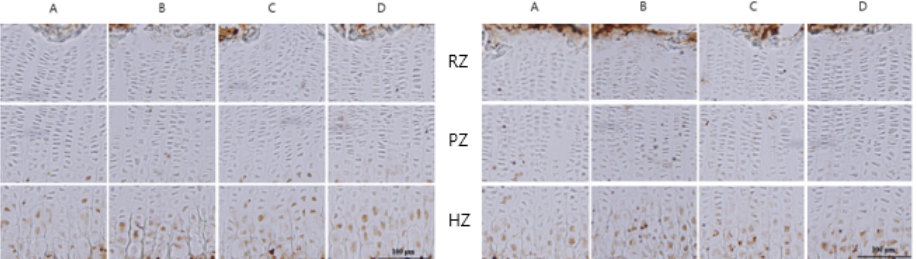
Figure 8. Immunohistochemical localizations of insulin-like growth factor-1 and bone morphoge- netic protein-2 on the proximal tibial growth plate in rats. ( A ) control, ( B ) rhGH 200 µg/kg (s.c.), ( C ) HT042 100 mg/kg (p.o.), ( D ) HT042 300 mg/kg (p.o.). RZ; Resting zones, PZ; Proliferative zones, HZ; Hypertrophic zones. Scale bar; 100 µm.